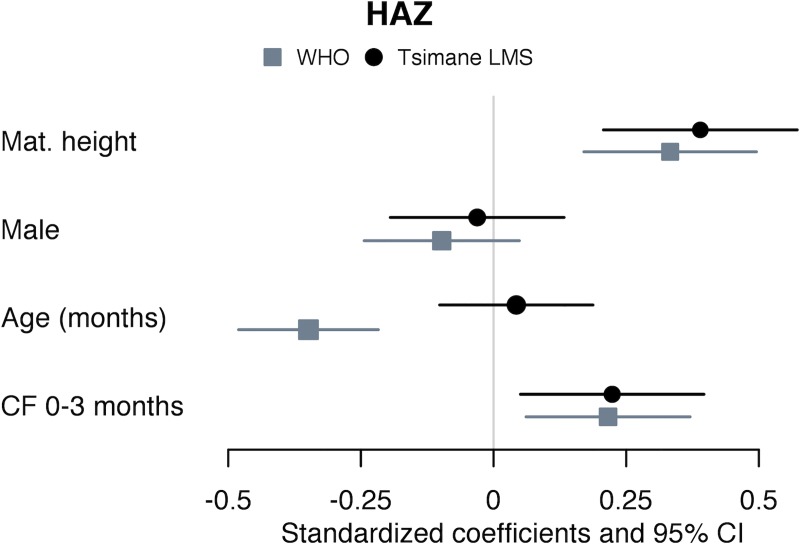
Forest plot of coefficient estimates from Models 8a-8b (mean and 95% CI).Mixed-effects liner regressions on WHO- and Tsimane-derived HAZ scores in children 6–35 months, with random intercept for subject (n subjects = 129; n observations = 198). Independent variables included maternal height (cm); infant sex (male vs. female); child age at measurement; and age at complementary feeding introduction (CF 0–3 months vs. CF 4–5 months).